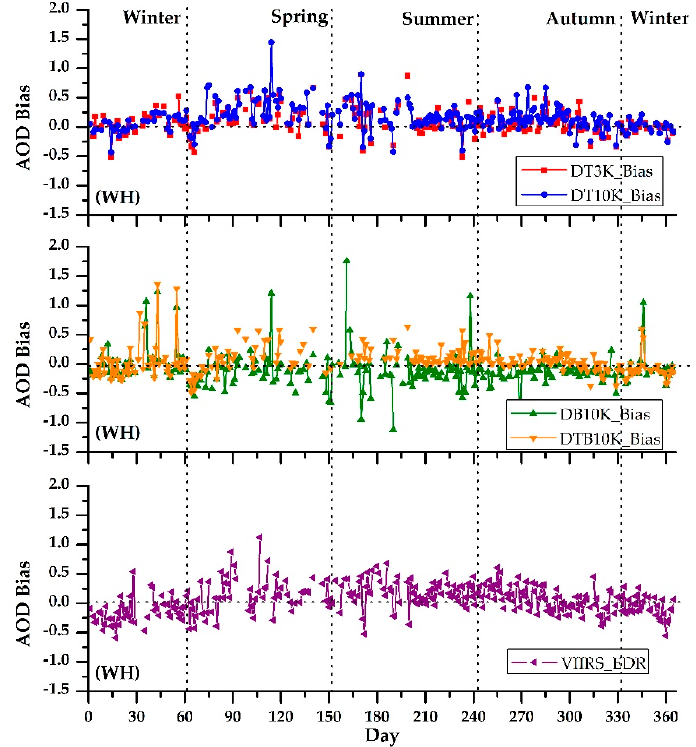
Figure 11. As in Figure 9, but for WH.